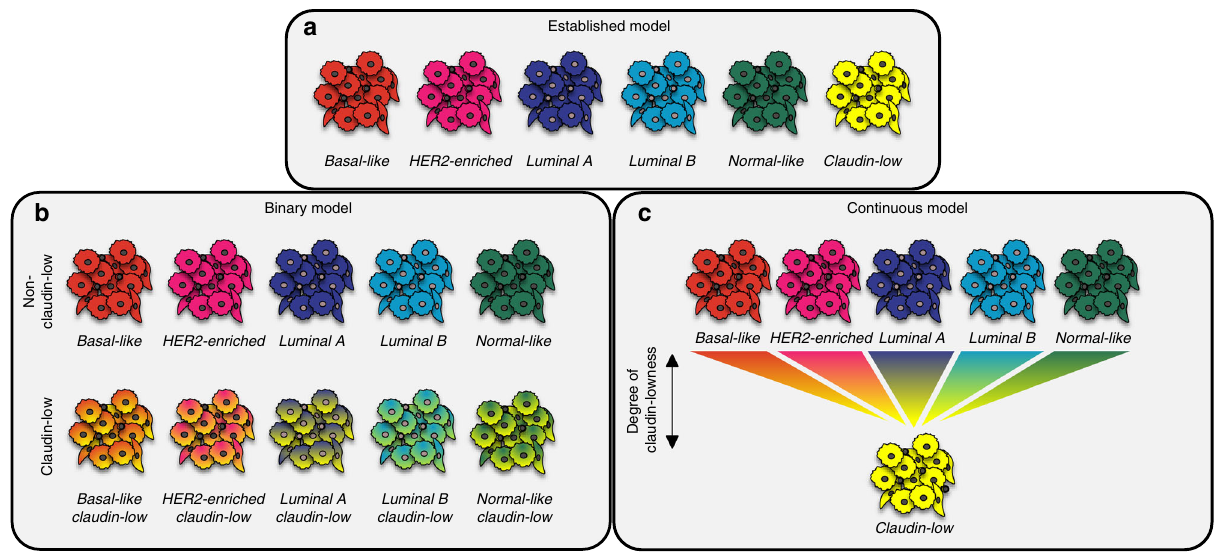
Fig. 6 Re-de fi nition of claudin-low as a breast cancer phenotype. a In the established model, claudin-low is interpreted as a sixth subtype, analogous to the intrinsic subtypes. b When strati fi ed by intrinsic subtype, claudin-low tumors, however, show characteristics associated with their intrinsic subtype. This implies that tumors are not claudin-low instead of their intrinsic subtype, rather that tumors can carry a claudin-low phenotype in addition to their intrinsic subtype. In the binary model, a tumor is either classi fi ed as claudin-low, or non-claudin-low. c The comparative analysis of CoreCL tumors and claudin-low tumors identi fi ed by the nine-cell line predictor, indicates that claudin-low may in fact be a continuous feature. Thus, individual tumors may show varying degrees of claudin-lowness, rather than simply being claudin-low or non-claudin-low. In this model, CoreCL tumors, on average, have a higher degree of claudin-lowness than claudin-low tumors identi fi ed by the nine-cell line predictor. The continuous model opens for the possibility of pure claudin- low tumors, uncoupled from the intrinsic